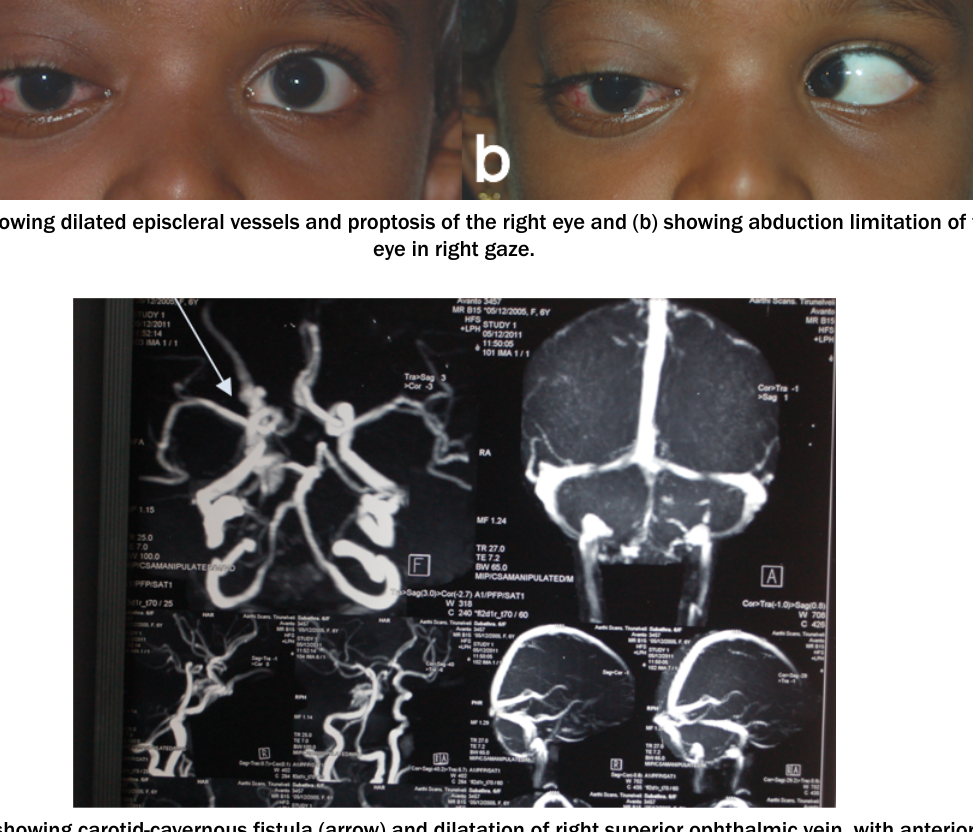
Figure 2: MRI showing carotid-cavernous fistula (arrow) and dilatation of right superior ophthalmic vein, with anterior venous drainage.